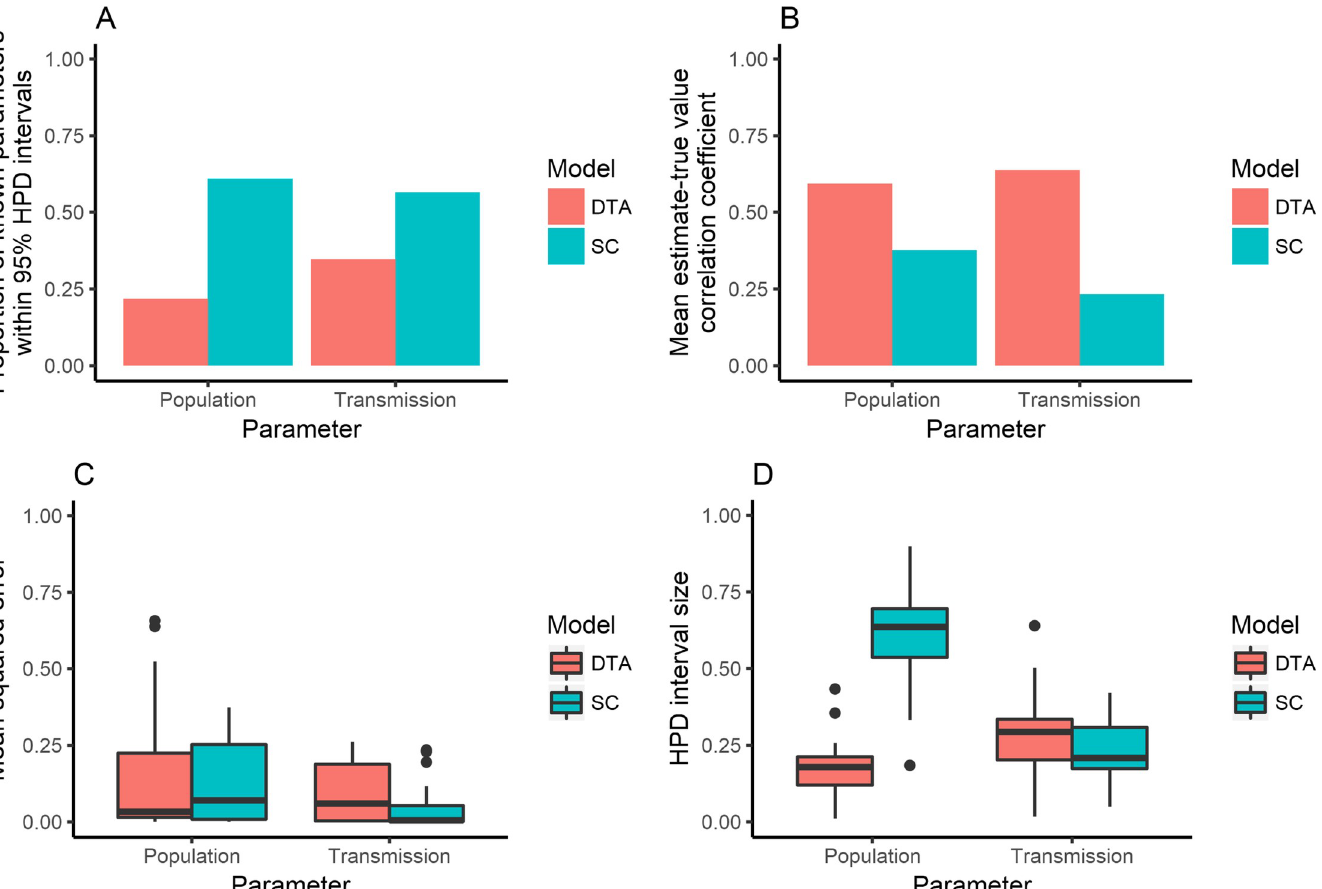
Fig 6. The proportion of outbreak simulations that the models included the known parameter within their 95% highest posterior density (HPD) intervals (A); the correlation coefficient between known parameters and the models’ mean estimates (B); the mean squared error between known parameters and the models’ mean estimates (C); and the size of the models’ 95% HPD intervals (D), for the population and transmission estimates made by the DTA (red) and SC (blue) models for 23 randomly-sampled simulated outbreaks that 100 isolates were randomly sampled